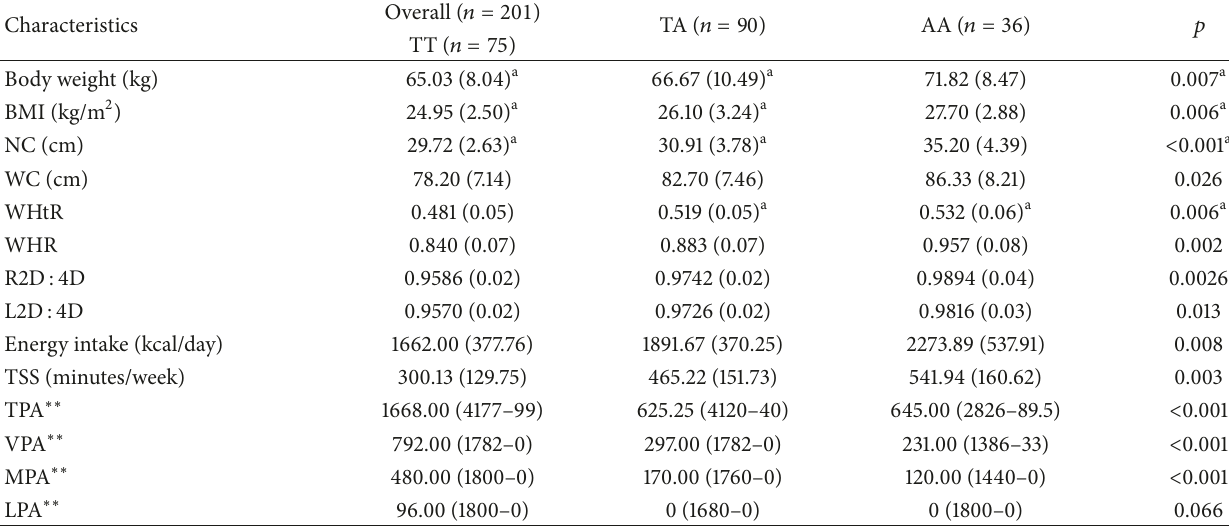
Table 2: Anthropometric traits of overweight and control subjects stratified by FTO rs6639609 variants. Characteristics